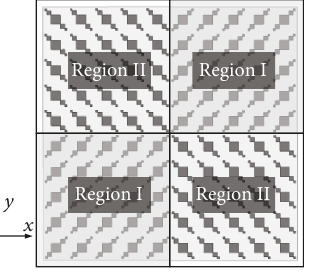
Figure 6: Con fi guration of the chessboard-like